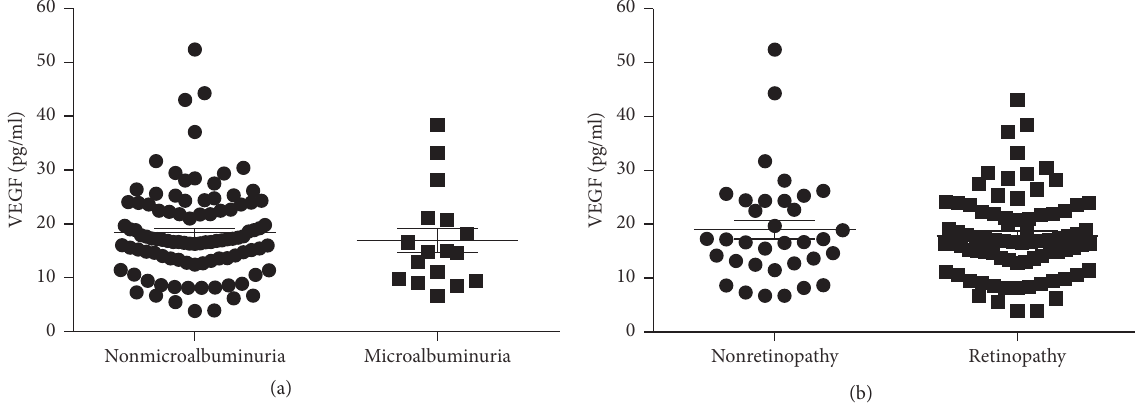
Figure 3: The levels of plasma VEGF are similar in patients with type 1 diabetes and microvascular complications when compared to patients without complications. Among the patients with T1D ( 𝑛 = 115 ), 𝑛 = 17 had microalbuminuria (defined as urine albumin between 30 and 300 mg/l) but the levels of plasma VEGF were similar as compared to patients without microalbuminuria (a). Also, patients with retinopathy ( 𝑛 = 81 ) had similar levels of plasma VEGF when compared to patients with a normal eye exam. An unpaired two-tailed 𝑡 -test based on ranks (Mann–Whitney) was applied in (a) since VEGF was not normally distributed. Values are given as mean ± SEM.